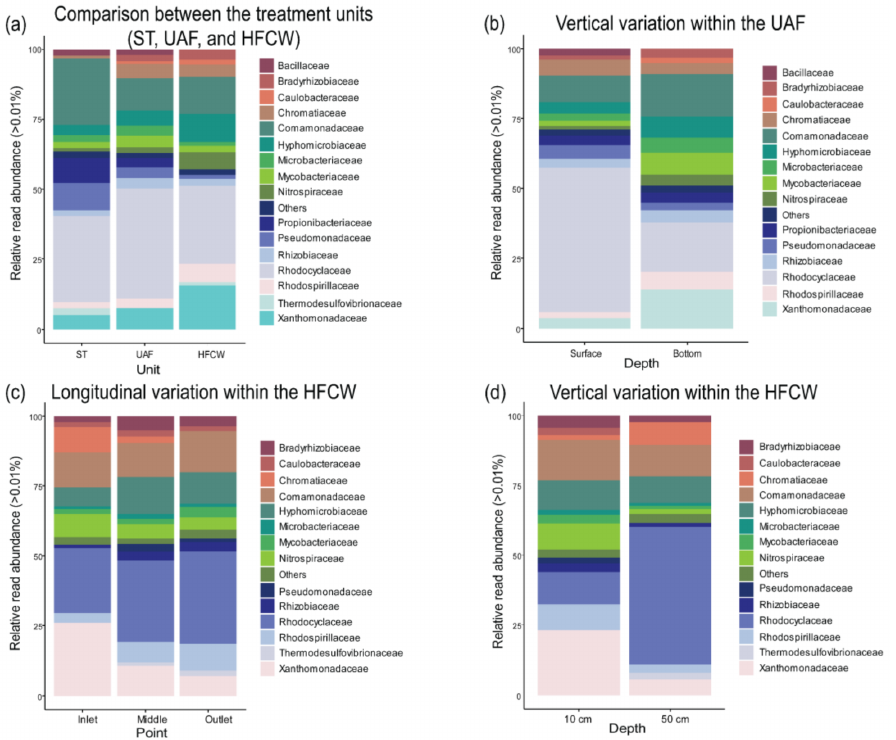
Figure 5. Nitrogen degrading families ( a ) Comparison between the treatment units (ST, UAF, and HFCW), ( b ) Vertical variation within the UAF, ( c ) Longitudinal variation within the HFCW, and ( d ) Vertical variation within the